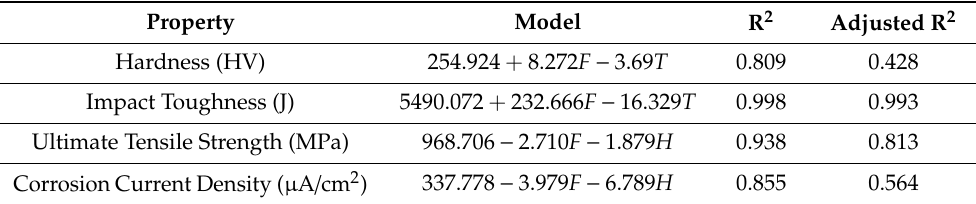
Table 17. Model summary for properties of duplex stainless steel in terms of ferrite phase